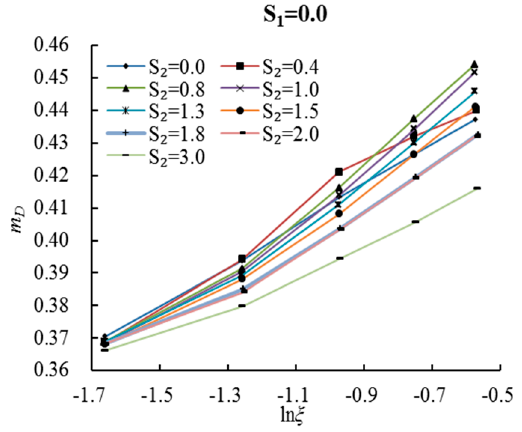
Figure 12. m D vs. ln ξ at S 1 = 0.0 for S 2 = 0.0–3.0.